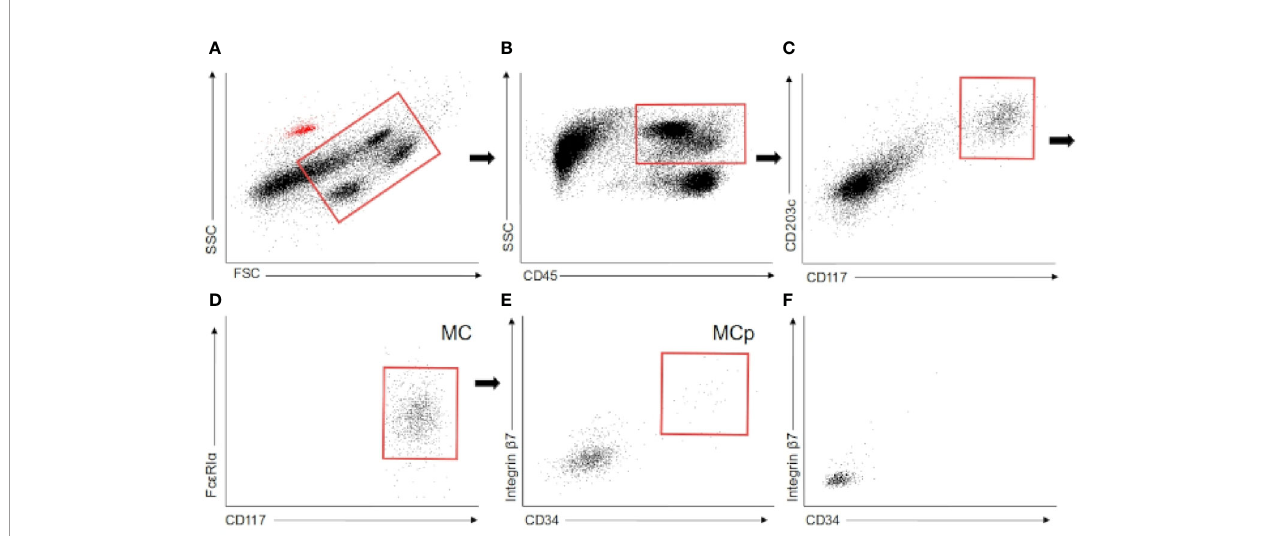
FIGURE 1 | Flow cytometry. (A – E) Flow cytometry gating employed to identify mast cells and mast cell progenitors in white adipose tissue. The red dots in the fi rst scatter plot are the auto fl uorescent beads employed in the quanti fi cation. (F) Mast cell progenitor gate in colonic mucosa. MC (mast cells), MCp (Mast cell